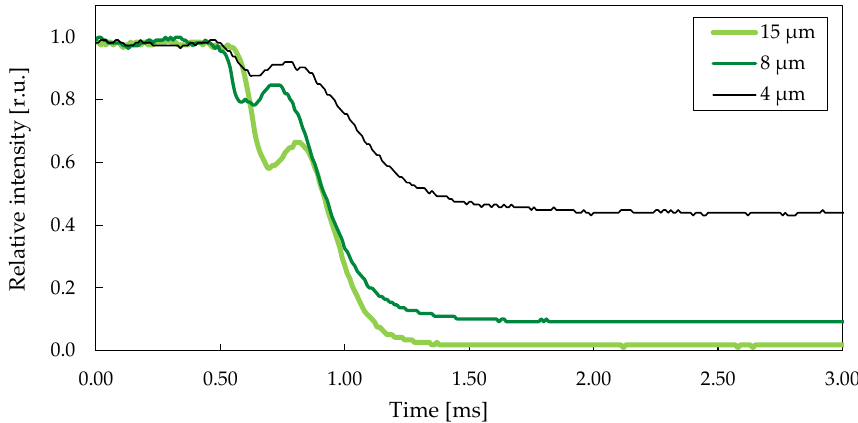
Figure 15. Electro-optical curve character for various cell gaps. Measurements with 525 nm green laser.